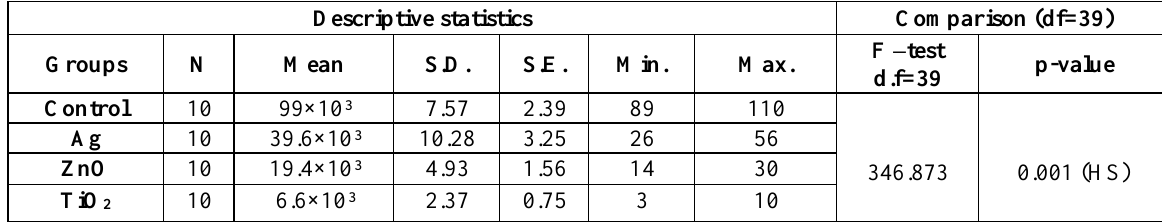
Table 2: Descriptive statistics and F-test (ANOVA) of the CFU/mL.